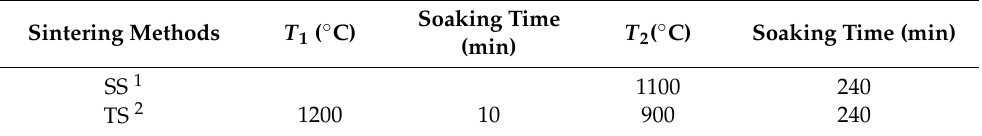
Table 2. Sintering conditions used in this